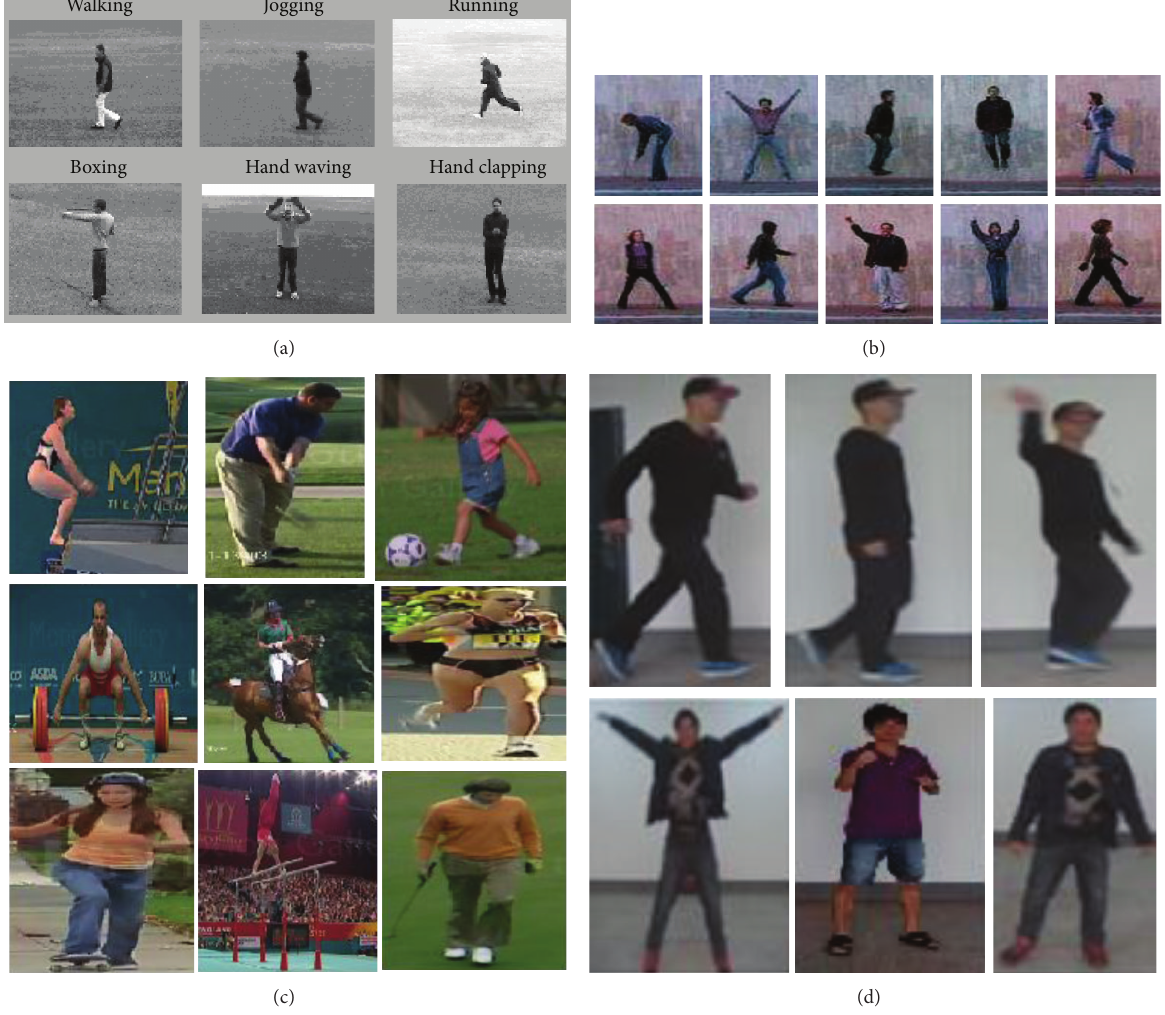
Figure 4: Sample frames from our datasets. The action labels in each dataset are as follows: (a) KTH dataset [33]: walking (a1), jogging (a2), running (a3), boxing (a4), and hand clapping (a5); (b) Weizmann dataset [21]: bending (a1), jumping jack (a2), jumping forward on two legs (a3), jumping in place on two legs (a4), running (a5), galloping sideways (a6), walking (a7), waving one hand (a8), and waving two